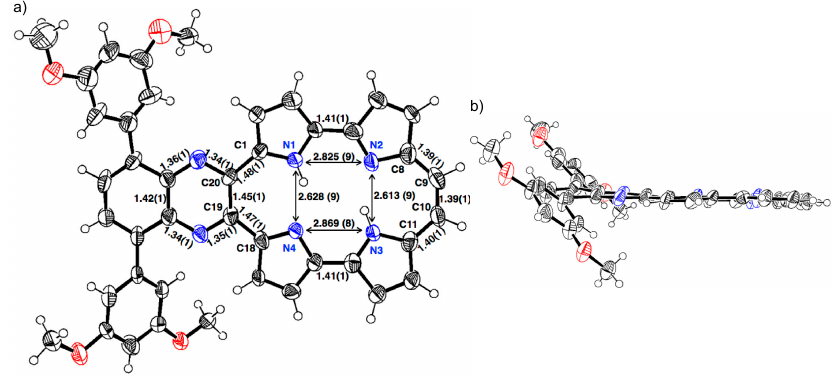
Figure 2. Crystal structure of 1b-H 2 . ( a ) Top view and selected bond lengths; ( b ) side view. Thermal ellipsoids represent for 50% probability.